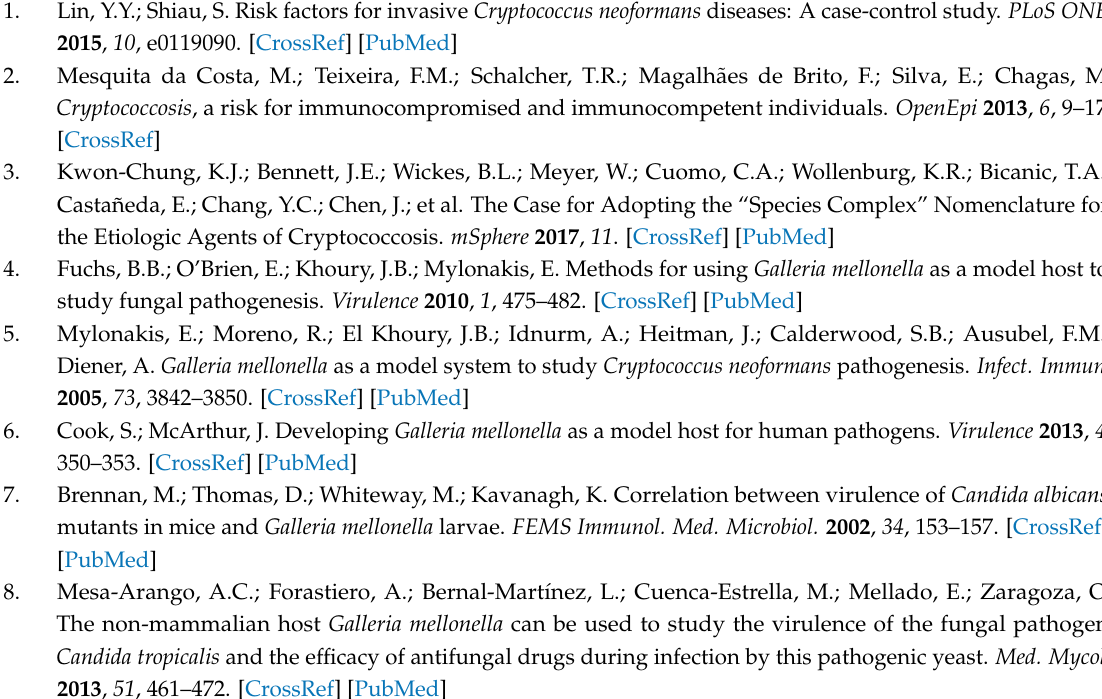
Table S1: General information of Cryptococcus neoformans and C. gattii clinical and environmental isolates according to species complex, sequence types (STs), macroscopic morphology, cellular and capsular size determination pre- and post-inoculation, mating type determination and mean survival in Galleria mellonella . Table S2: Control strains of Cryptococcus neoformans and C. gattii used in the study of virulence in the invertebrate model of Galleria mellonella and in phenotypic assays. Figure S1: Flowchart of the methodology used. Figure S2: Survival curves of G. mellonella inoculated with C. neoformans (1a clinical isolates-2a environmental isolates). Survival curves of G. mellonella inoculated with C. gattii (1b clinical isolates-2b environmental